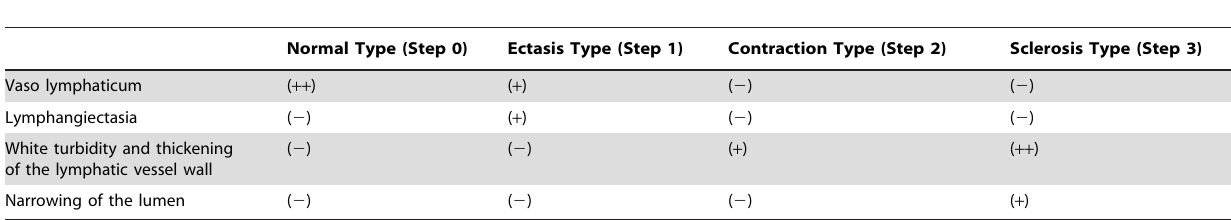
Table 2. (Online only) Classification of the types of collecting lymphatic vessels and the macroscopic anatomical findings (NECST).